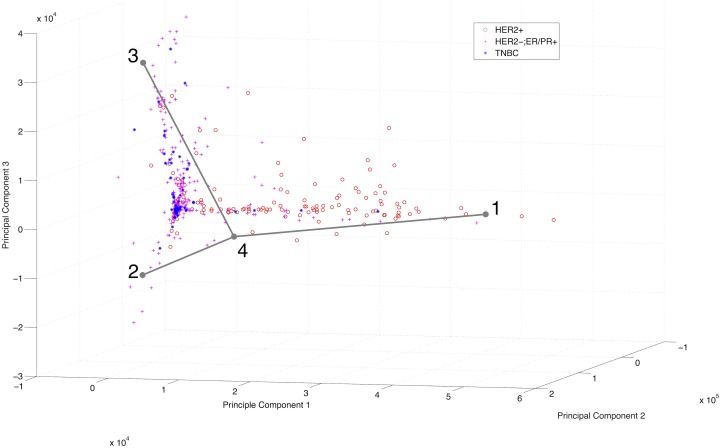
Visualization of TCGA CNV data with inferred maximum likelihood simplicial complex structure.The inferred structure of three arms sharing a point corresponds to a phylogeny of one most recent common ancestor, and three branches of a tree. Data points, corresponding to distinct tumor samples plotted in principal component space, are color coded by immunohistological subtype (red circle: Her2+, purple plus: ER/PR+, blue asterisk: triple-negative).